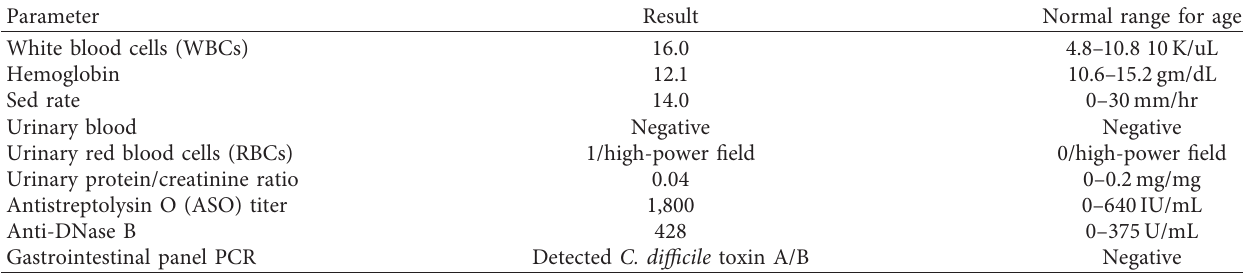
Table 1: Pertinent basic and infectious laboratory results of our